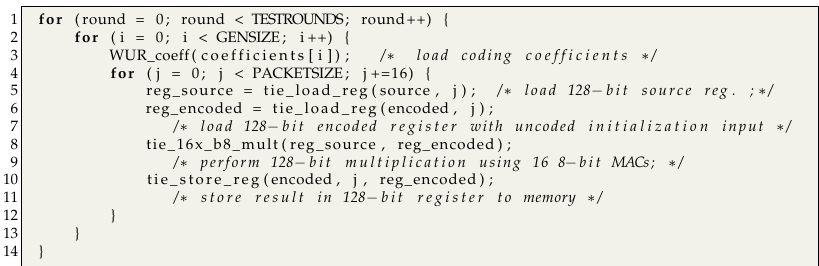
Figure 2. Block diagram of the single instruction multiple data (SIMD) multiplier for 8-bit operands:16 MAC units were employed in parallel to conform to the 128-bit memory interface of the LX5 processor.